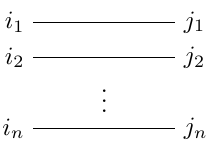
Figure 9 . The state ( i 1 ; j 1 ) : : : ( i n ; j n